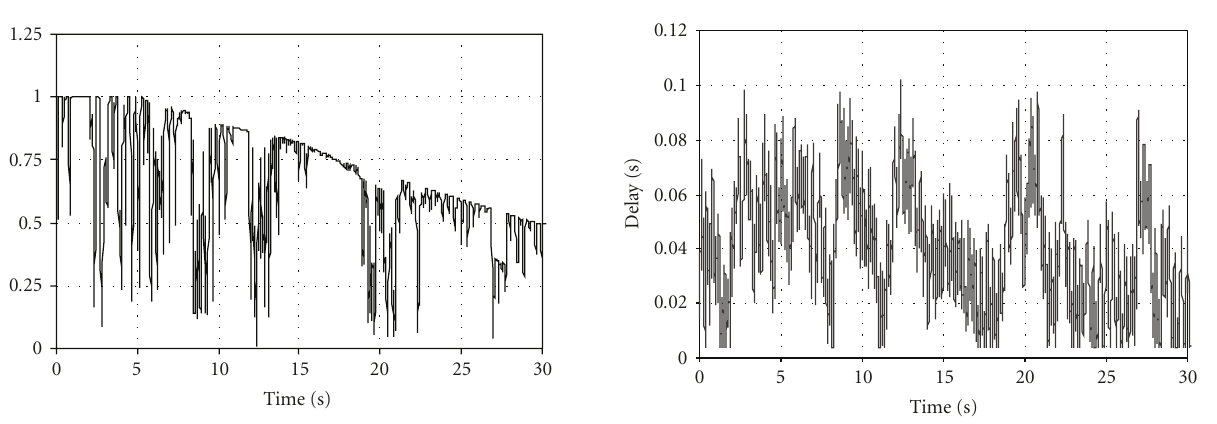
Figure 8: Output from stage two of the FLC, with a = 2.